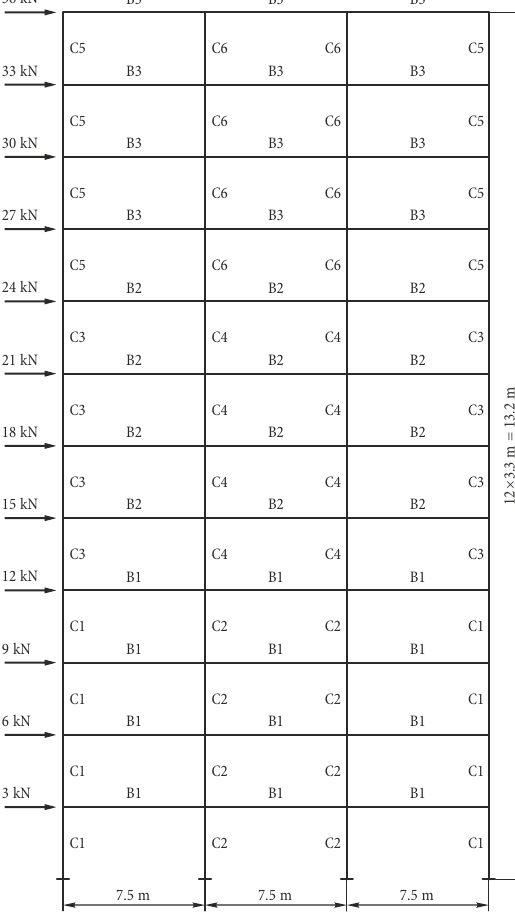
Fig. 15. Grouping of beams and columns in the third model